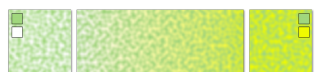
Figure 9: Simple color interpolation of Perlin noise texture If the two colors of the procedural textures to be interpolated are different, the interpolation is done by two steps, using a pivot symbolization created with a color of both ends’ textures: in the figure 10, the first color is interpolated between light green and dark green (on the right) and the second color is interpolated be- tween white and yellow (on the left). Figure 10: Double color interpolation of Perlin noise texture Between two baselayer rasters The third example aims at cre- ating a graphic path between two possible base layers: a white baselayer and an orthoimage. The interpolation is made in two steps in order to manipulate separately the color and the natu- ral texture of the imagery. In consequence, the imagery is first converted in greyscale and then the color of every pixel is inter- polated first from its natural color to the greyscaled one and sec- ondly from the greyscaled color to white. The figure 11 shows interpolation result samples.